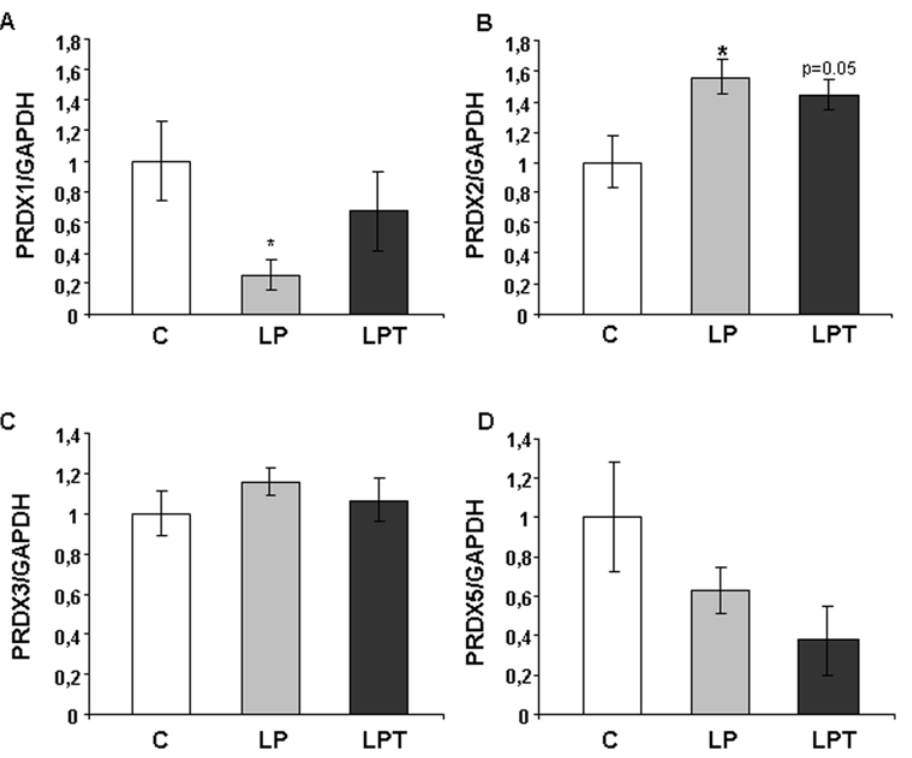
Figure 7. PRDX1 (A), PRDX2 (B), PRDX3 (C) and PRDX5 (D) gene expression in pancreatic islets from 3 month-old rats. Results are expressed as means 6 SEM; n=6–7 independent experiments. *p , 0.05, **p , 0.01 vs C;